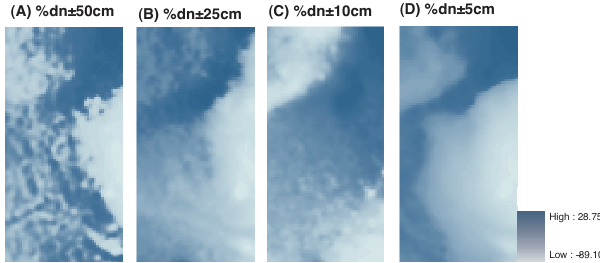
Fig. 9. Percentages of differences normalised of flow depth re- sults using each subscale scheme, namely ± 50cm (A) , ± 25cm 864 (B) , ± 10cm (C) , ± 5cm (D) compared with those obtained using Figure 9. Percentages of differences normalised of flow depth results using each subscale scheme, 865 a reference one namely ± 50cm (a), ± 25 cm (b), ± 10 cm (c), ± 5 cm (d) compared with those obtained using a 866